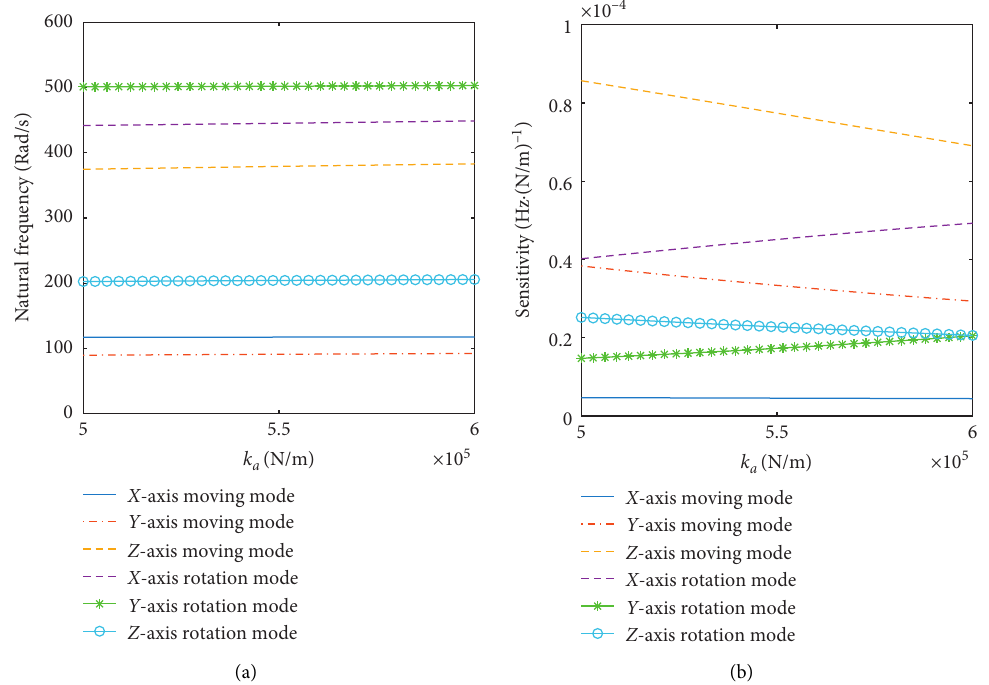
Figure 9: Curve of variation of natural frequency and its sensitivity with stiffness of outer leg 1. (a) Natural frequency. (b) Sensitivity of natural frequency to the stiffness of outer leg 1.